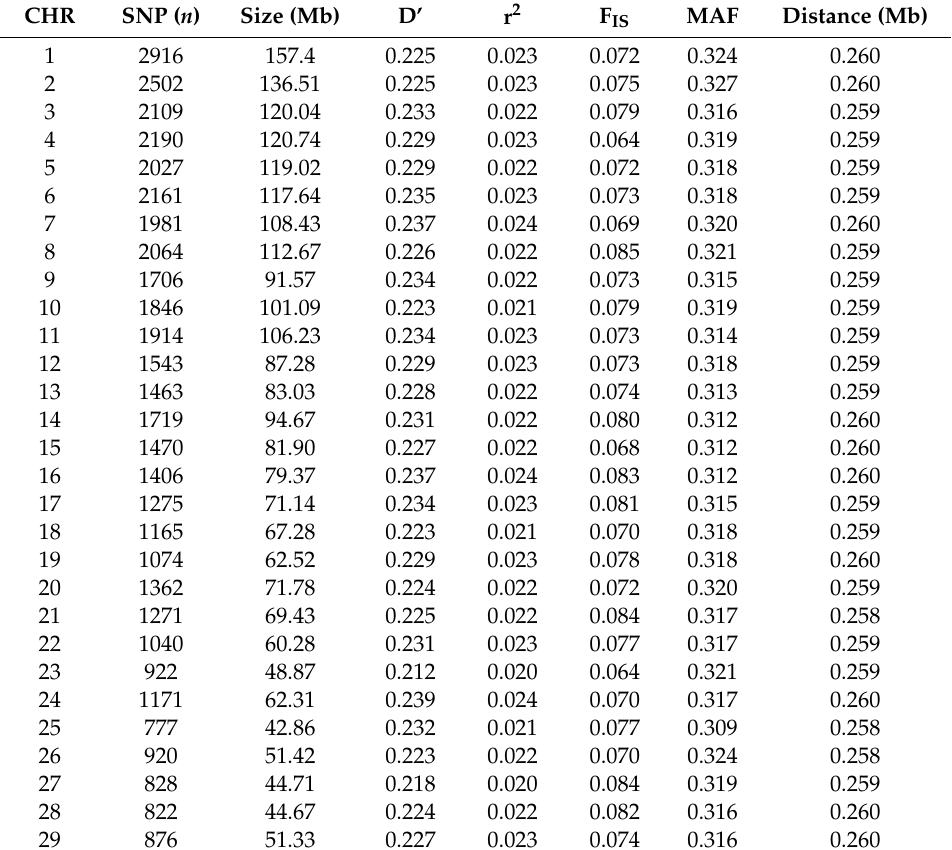
Table 3. Summary of analyzed markers and average linkage disequilibrium (r2 and D’) separated by di ff erent distances across the 29 autosomal